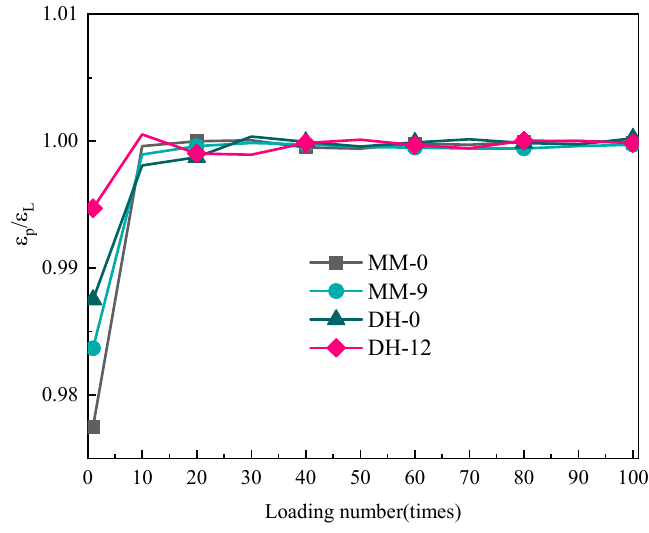
Figure 8. Results of ε L / ε p as a function of the number of loads before aging.